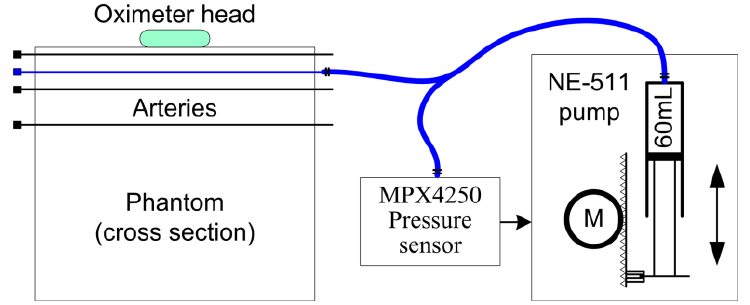
Figure 2. Generation of intra-arterial pressure waves in the phantom (emulating heart beats) by an electronically controlled pump. The pump can be connected to any of the arteries in the phantom with a Luer Lock fitting. The actual artery is marked in blue.